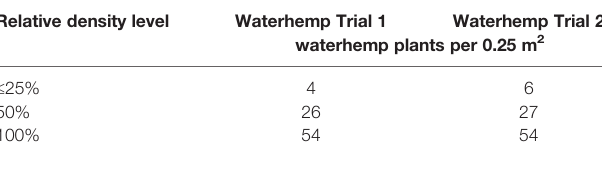
TABLE 2 | Relative density levels as compared to the natural populations of waterhemp in 0.25-m 2